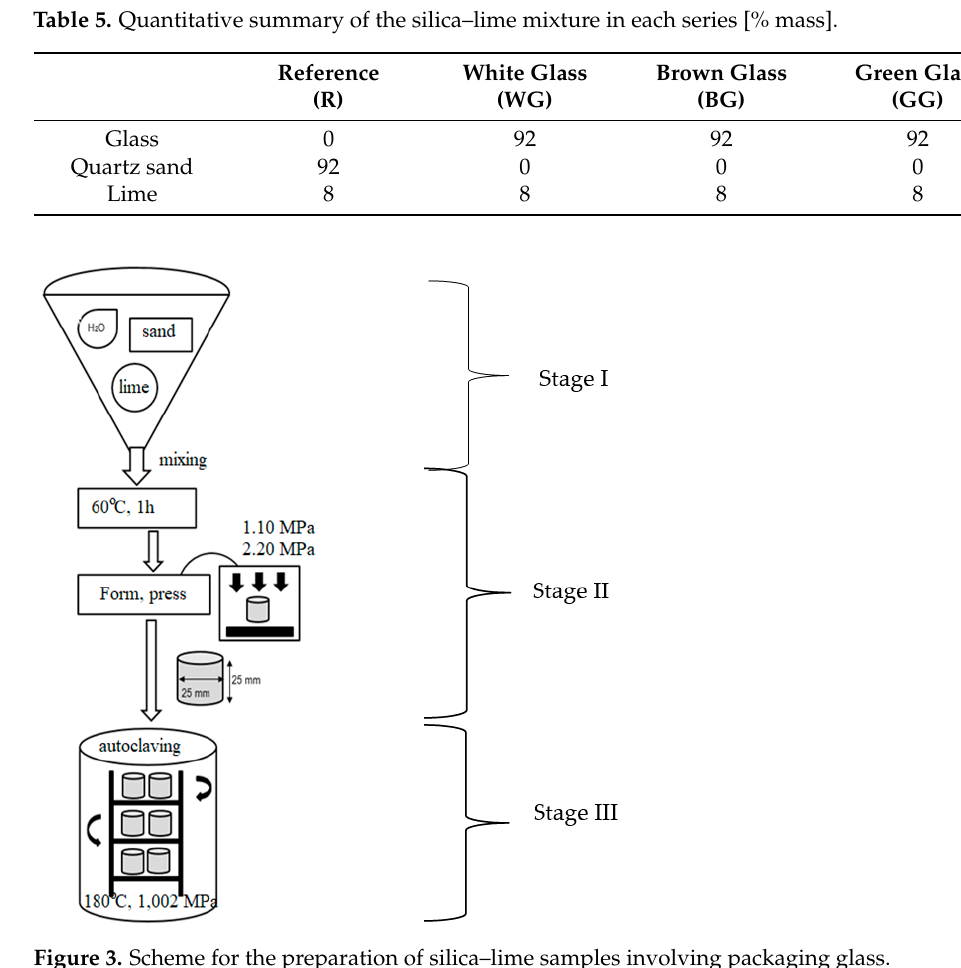
Figure 4. Broken silica–lime sample with GG after compressive strength